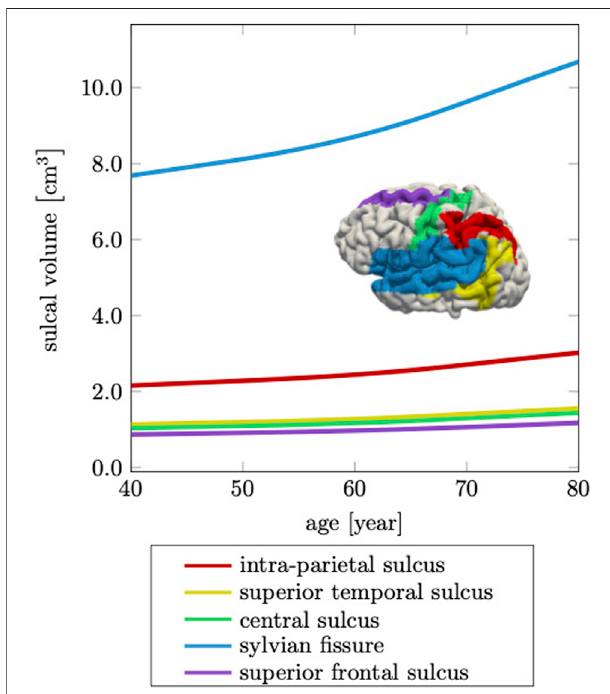
FIGURE 10 | Cerebral atrophy includes sulcal widening, or the increase in intra-sulcal volume due to the shrinking of surrounding tissue. The sylvian fi ssure, which separates the frontal and parietal lobes from the temporal lobe, increases most by 39%, while the other sulci increase on average by 36% over a 40 years time